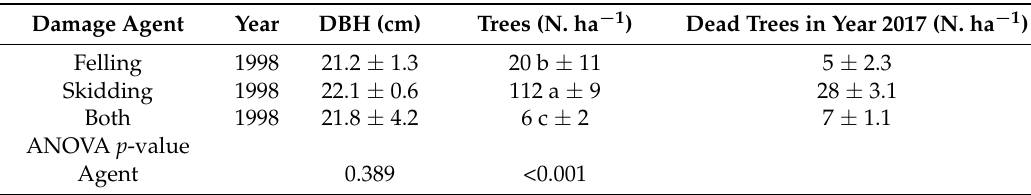
Table 4. Damage agent in trees and diameter at breast height ( ± SD) after thinning in 1998 and dead trees in 2017.